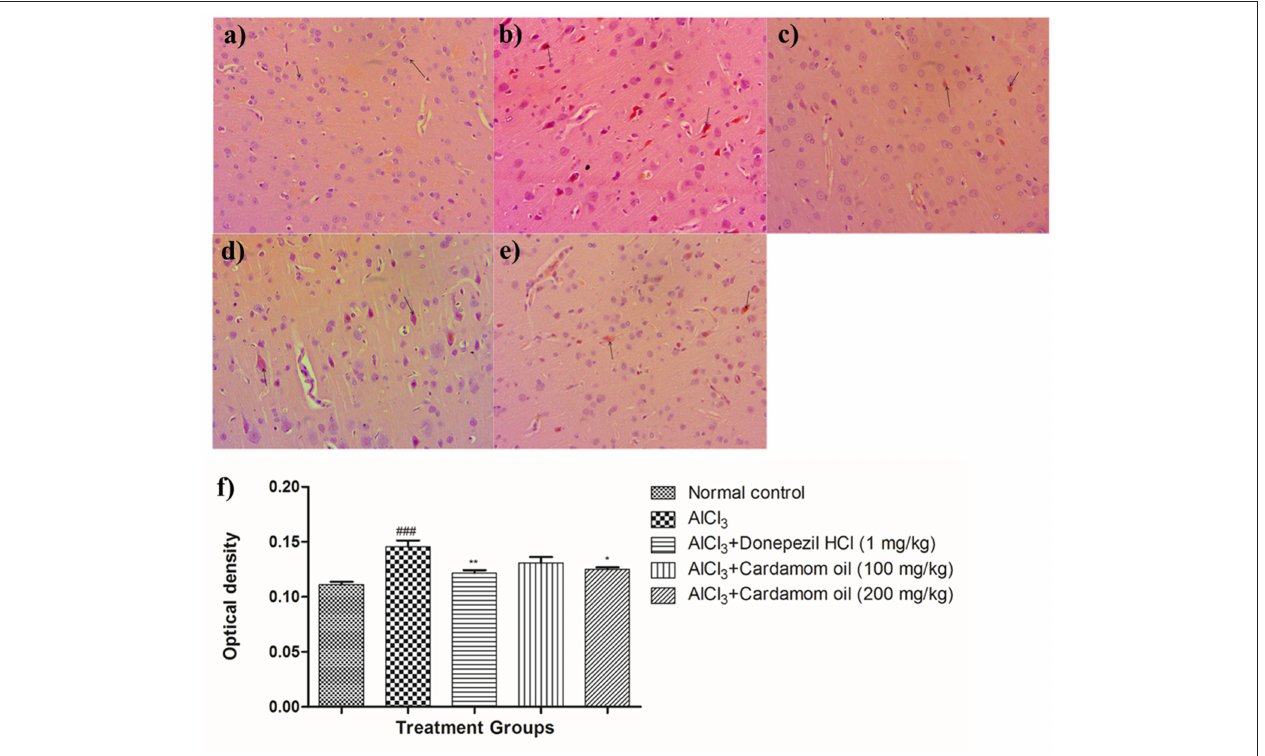
FIGURE 8 | Effect of Cardamom oil on Congo red stained cortex tissue (400X). (a) Normal control: Cortex: showing normal histology, normal neuronal cells in (small arrow) {Congo Red, 400X}, (b) AlCl 3 group: Cortex: showing multifocal moderate deposition of amyloid β plaques (arrow) {Congo Red, 400X}, (c) AlCl 3 + Donepezil hydrochloride (1 mg/kg): Cortex: showing multifocal mild deposition of amyloid β plaques (arrow) {Congo Red, 400X}, (d) AlCl 3 + Cardamom oil (100 mg/kg): Cortex: showing multifocal moderate deposition of amyloid β plaques (arrow) {Congo Red, 400X}, (e) AlCl 3 + Cardamom oil (200 mg/kg): Cortex: showing multifocal mild deposition of amyloid β plaques (arrow) {Congo Red, 400X} (f) Histogram of congo red staining. Data are expressed as mean ± SEM ( n = 6), ### p < 0.001 when compared with normal control, ** p < 0.01, * p < 0.05 when compared with disease control group. The magnification was 400X. AlCl 3 , Aluminum chloride; SEM, Standard Error of